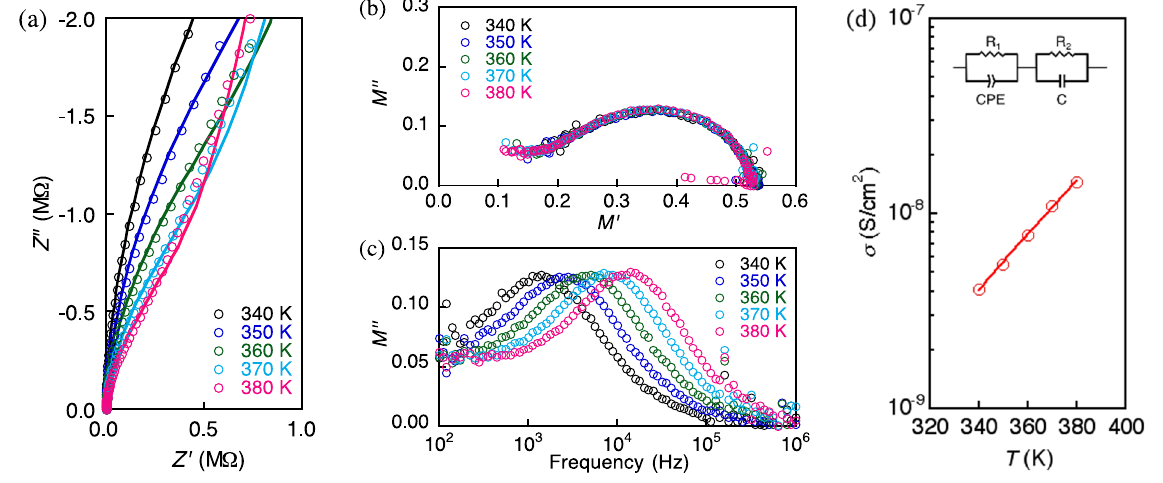
Figure 4. ( a ) Complex impedance Z ′ – Z ″ plots of 1 at selected temperatures. The solid lines represent the fit result using the equivalent circuit shown in the inset of (d); ( b )